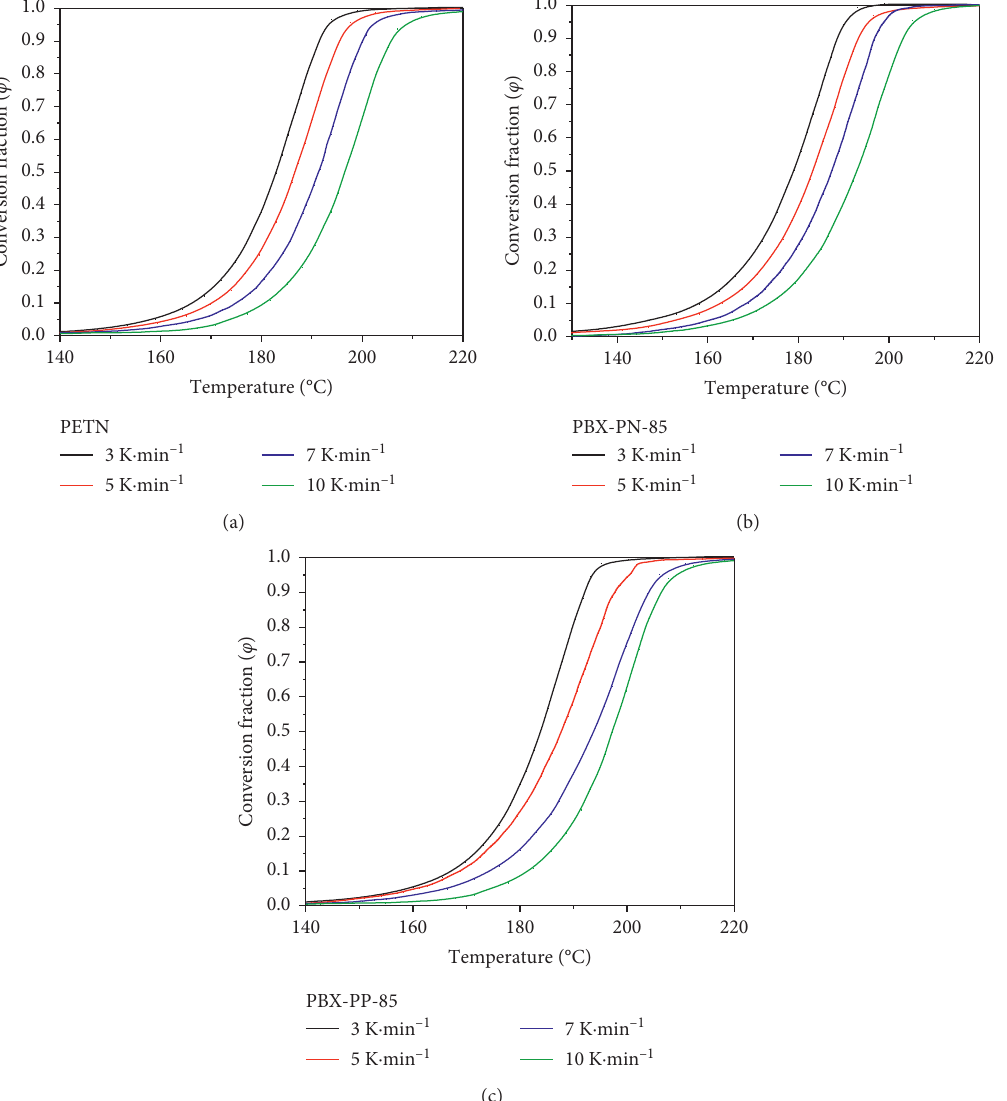
Figure 2: φ versus T curves of PETN, PBX-PN-85, and PBX-PP-85 at several heating